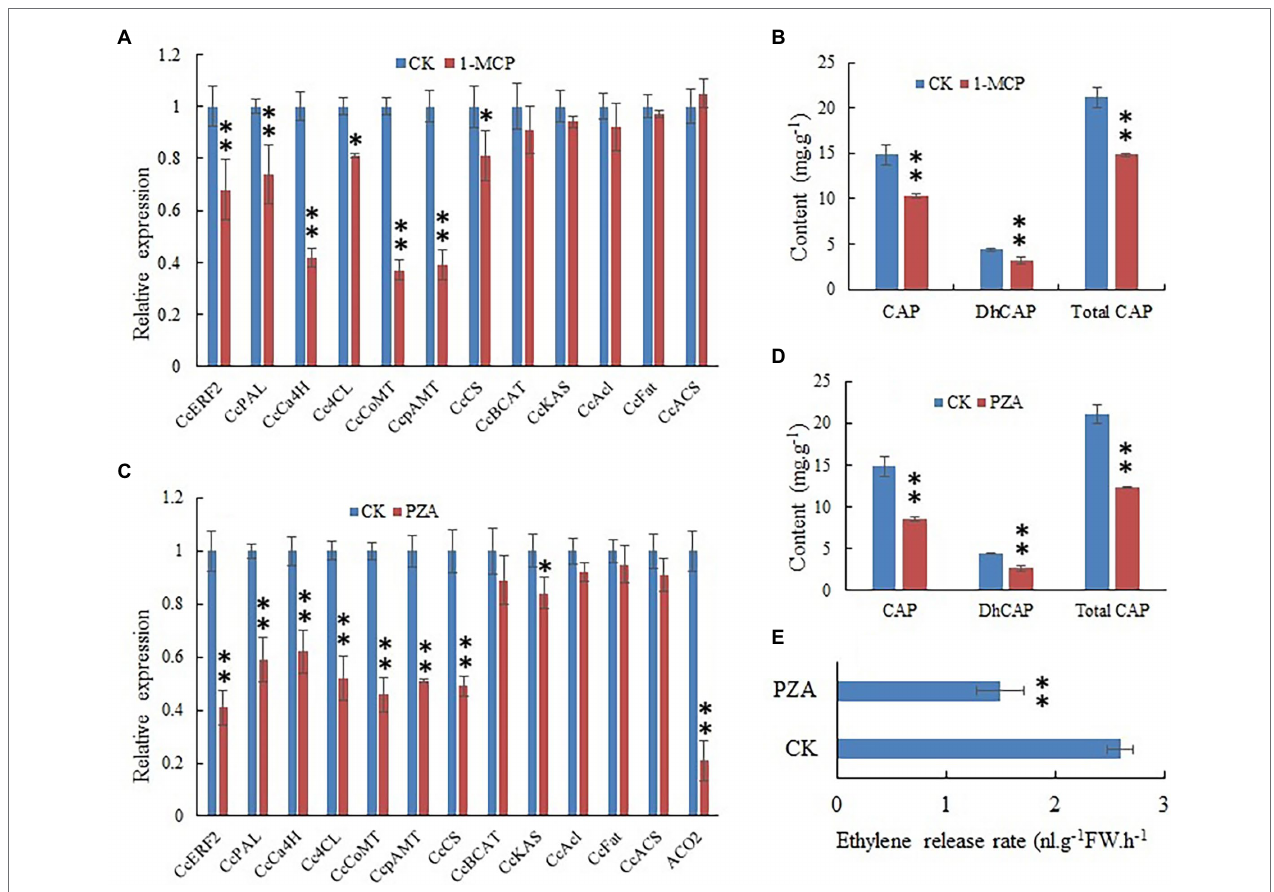
FIGURE 7 | Expression level of CBGs and CcERF2 , relative contents of capsaicin (CaP), dihydrocapsaicin (DhCaP), and CAPs in 1-methylcyclopropene (1-MCP) and pyrazinamide (PZA) treatment fruit. (A) Expression level of CBGs and CcERF2 in the 1-MCP treatment fruit. Fruits at 24 DAP was sampled to perform the expression level of CBGs and CcERF2 . The relative expression level of the CBGs and CcERF2 in the control were set to 1, and that of in 1-MCP treatment fruit were measured relative to that in the control. (B) Relative contents of CaP, DhCaP, and CAPs in the 1-MCP treatment fruit at 29 DAP. (C) Expression level of CBGs, CcERF2 , and ACC oxidase-2 ( ACO2 ) in the PZA treatment fruit. Fruits at 24 DAP was sampled to perform the expression level of CBGs and CcERF2 . The relative expression level of the CBGs and CcERF2 in the control were set to 1, and that of in PZA treatment fruit were measured relative to that in the control. (D) Relative contents of CaP, DhCaP, and CAPs in the PZA treatment fruit at 29 DAP. (E) Ethylene release rate in the PZA treatment fruit at 29 DAP. The experiments were replicated three biological times and three technical times. Data are expressed as the mean ± SD ( n = 9). Student’s t -test was used to identify significant differences compared to the control ( * p < 0.05, ** p <